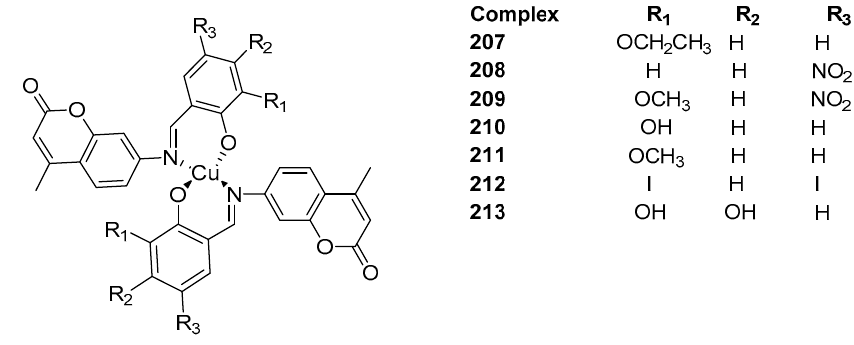
Figure 69. Chemical structure of complexes 207–213.